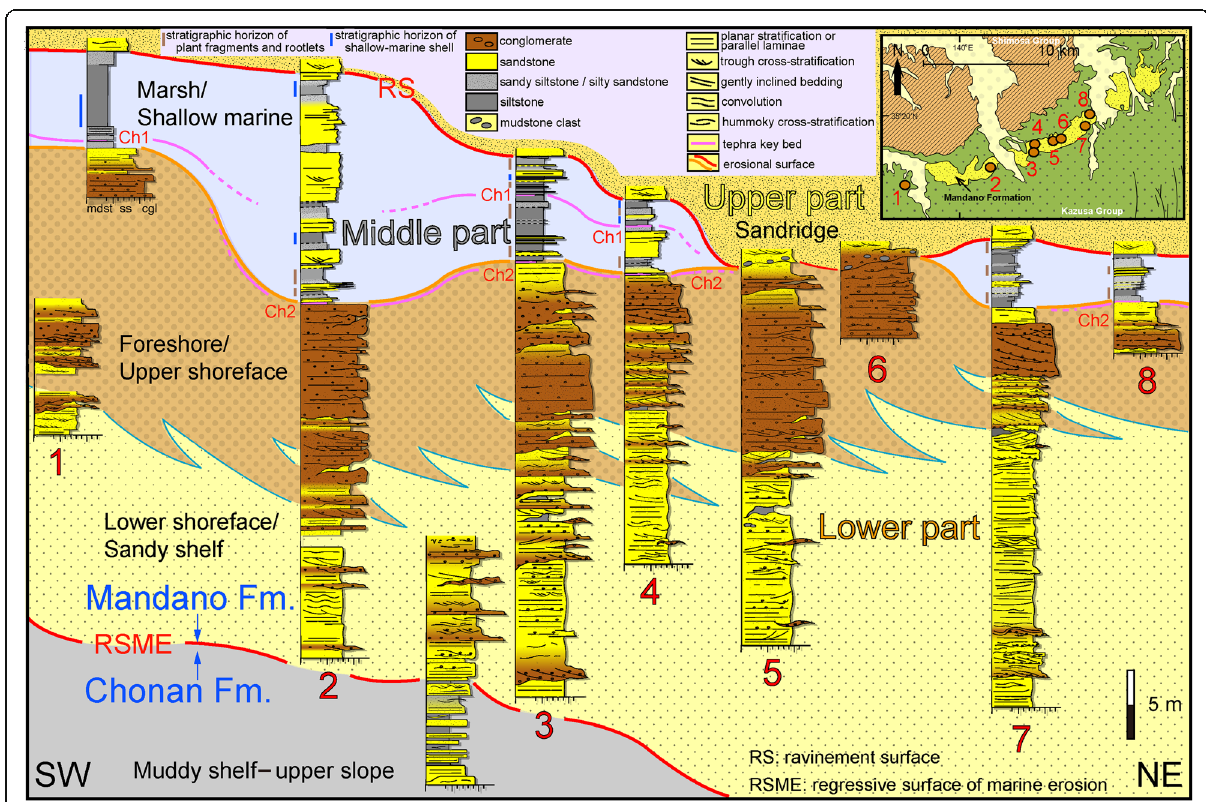
Fig. 7 Stratigraphic cross-section of the Mandano Formation. The inset map shows the distribution of the Mandano Formation and the locations of the measured